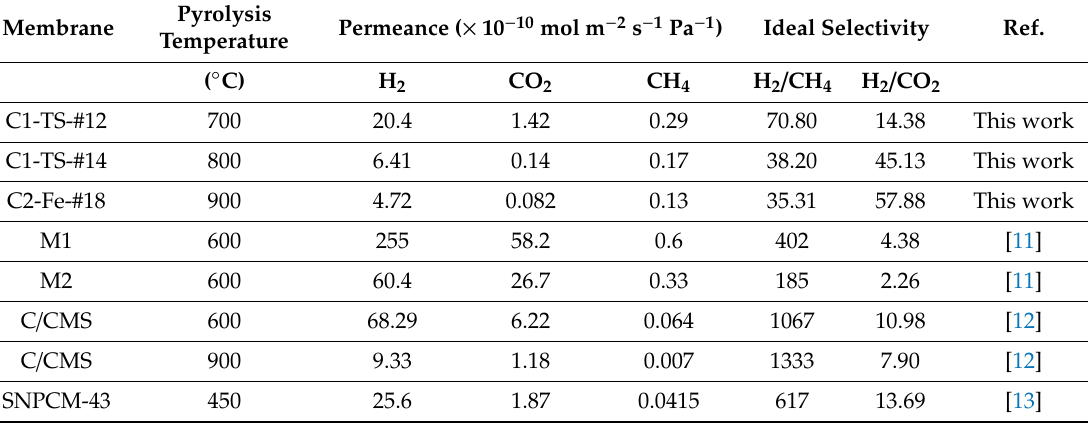
Table 4. Comparison of H 2 , CO 2 and CH 4 permeance and corresponding H 2 / CH 4 and H 2 / CO 2 selectivity of C1-TS and C2-Fe membranes with references from the